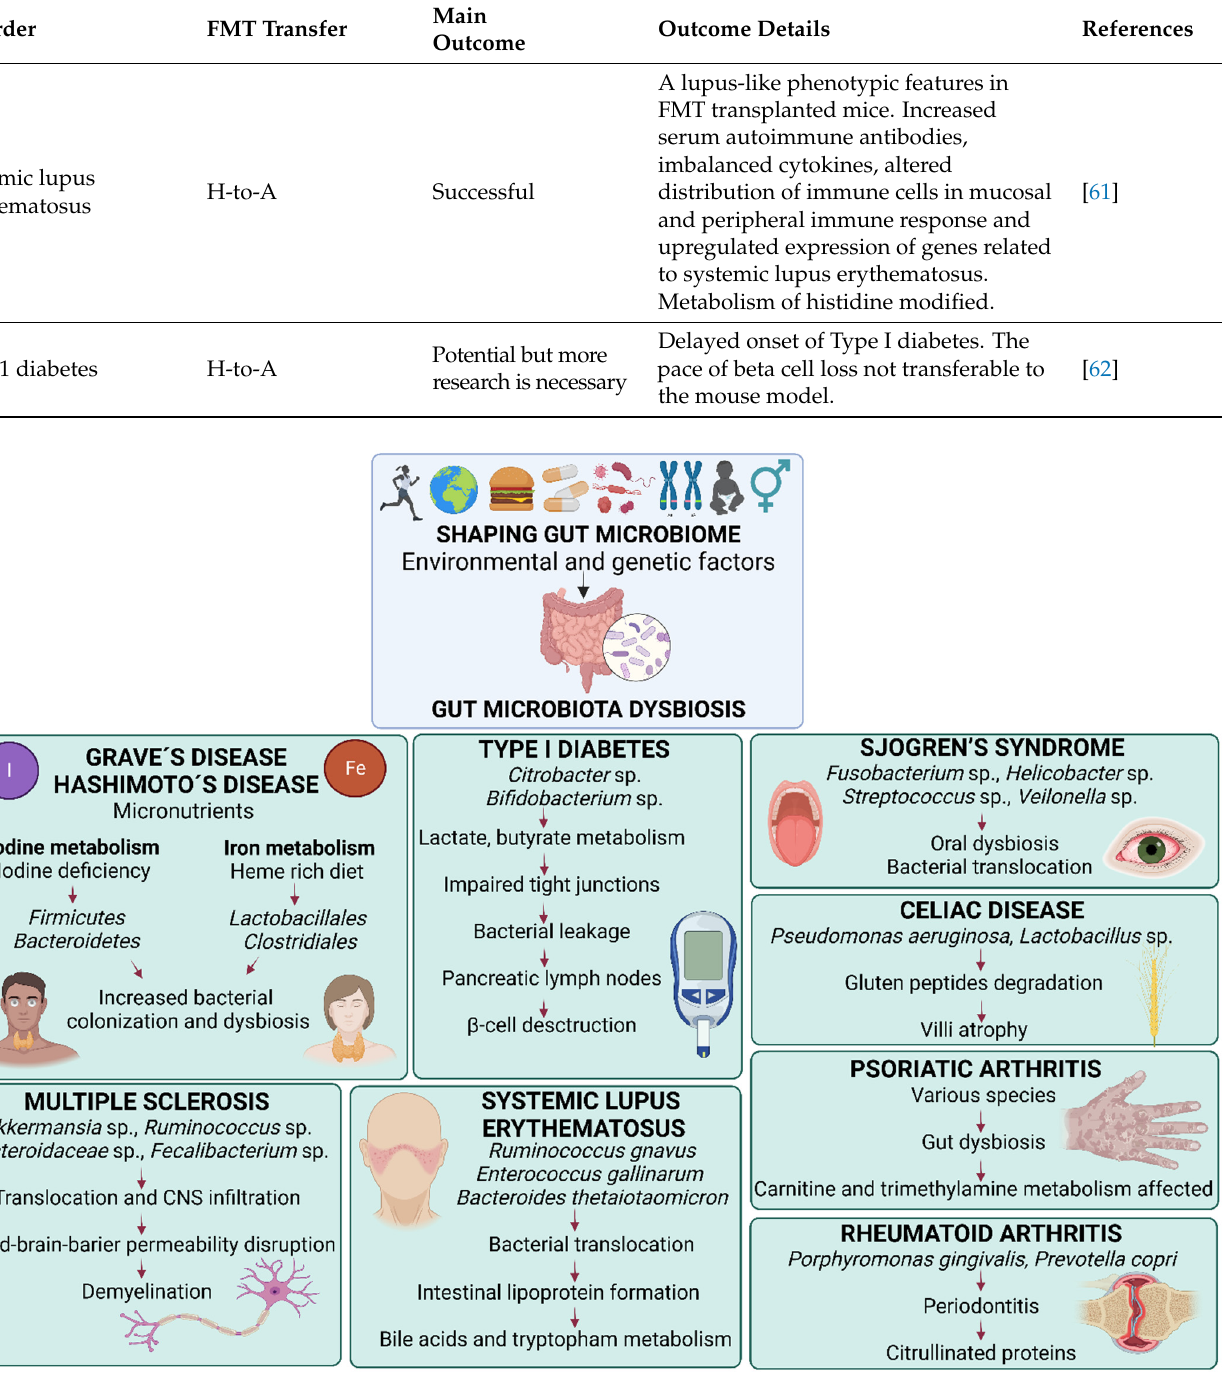
Figure 1. Changes in the composition of gut microbiota in selected autoimmune disease and proposed mechanisms of action. Gut microbiota is shaped by numerous environmental and genetic factors, namely age, sex, lifestyle, geographic location, diet, probiotics, drugs, genetic predisposition and previous infections. Its shift towards microbial dysbiosis increases gut barrier permeability, known as “leaky gut”, is characterized by the presence microbe-associated molecular patterns (MAMPs) and pathogen-associated molecular patterns (PAMPs), increased concentrations of lipopolysaccharides (LPS) and the release of proinflammatory cytokines in the circulation. Gut dysbiosis and increased gut permeability can play roles in the onset and progression of autoimmune diseases, namely: Graves´ disease and Hashimoto´s disease by modifying micronutrients metabolism, iodine and iron, that decrease intestinal pH; type I diabetes by bacterial translocation into pancreatic lymph nodes affecting β -cell destruction; psoriatic arthritis by carnitine and trimethylamine production in the gut; Sjogren´s disease by primary oral dysbiosis and following bacterial translocation via the bloodstream; Celiac disease by gluten peptides degradation and subsequent villi atrophy; systemic lupus erythematosus by lipoprotein formation, bile acid and tryptophan metabolisms; rheumatoid arthritis associated with oral gut microbiota dysbiosis, characterized by increased citrullinated pro- teins and anti-citrullinated protein antibodies; and lastly, multiple sclerosis by bacterial transloca-